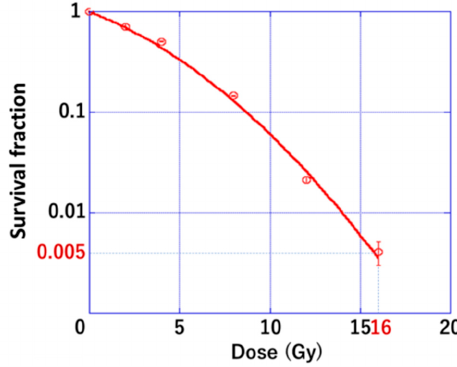
Figure 1. A cell survival curve of Pan02 cell line.